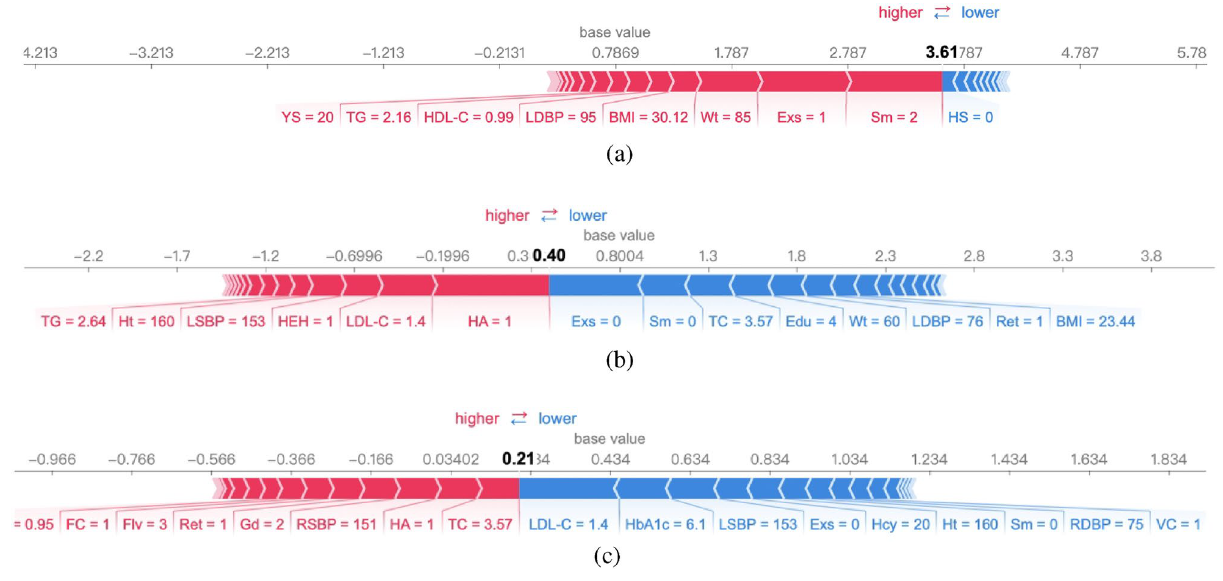
Figure 4. Explanation of two samples correctly predicted to be high-risk. ( a ) Force plot of prediction (0, 0, 3.6051, 0) on high-risk ( b ) Force plot of prediction (0, 0, 0.40, 0.21) on high-risk. ( c ) Force plot of (0, 0, 0.40, 0.21) on attack state.